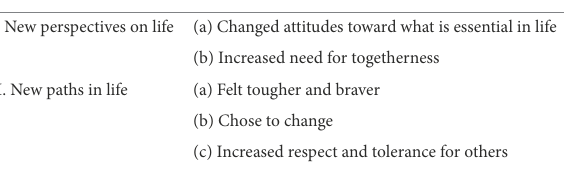
TABLE 5 Two main themes describing positive changes ( n = 14). Themes